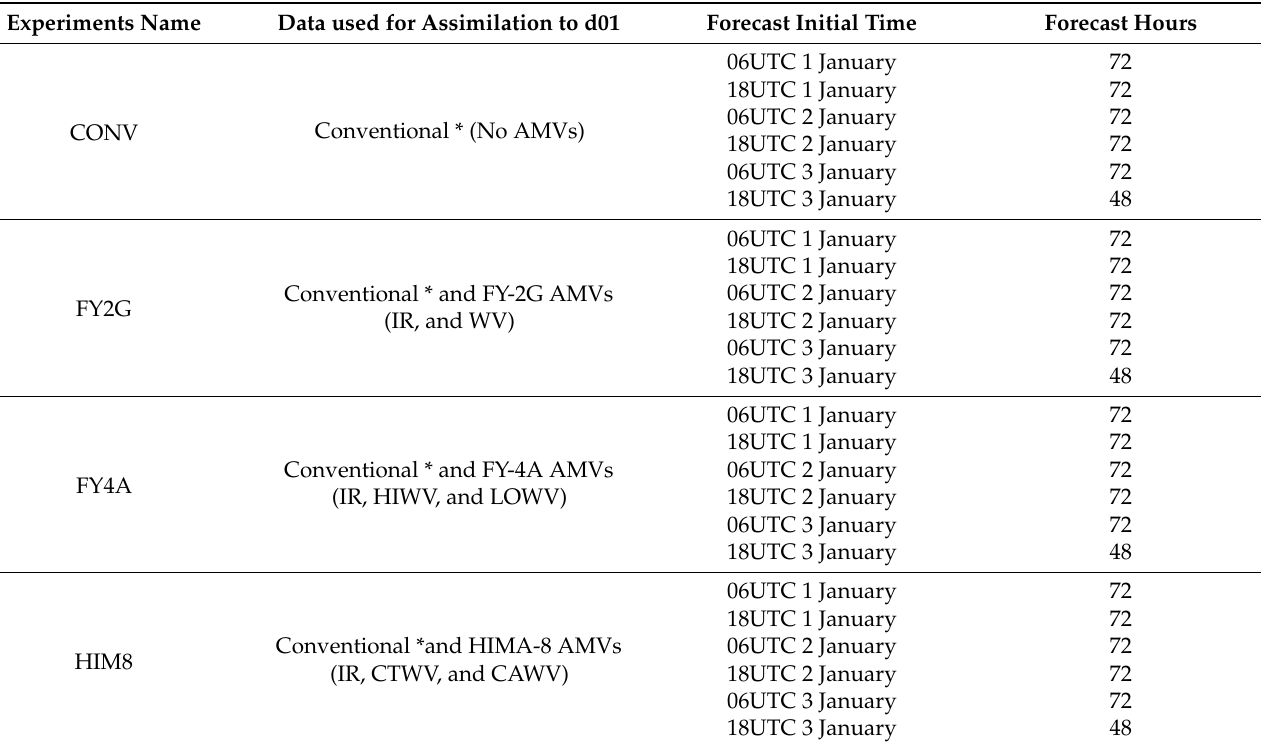
Table 1. Description of the four sets of assimilation experiments at different initial conditions every 12 h. All AMVs observation selection for experiments at QI 85% start from 1 to 3 January